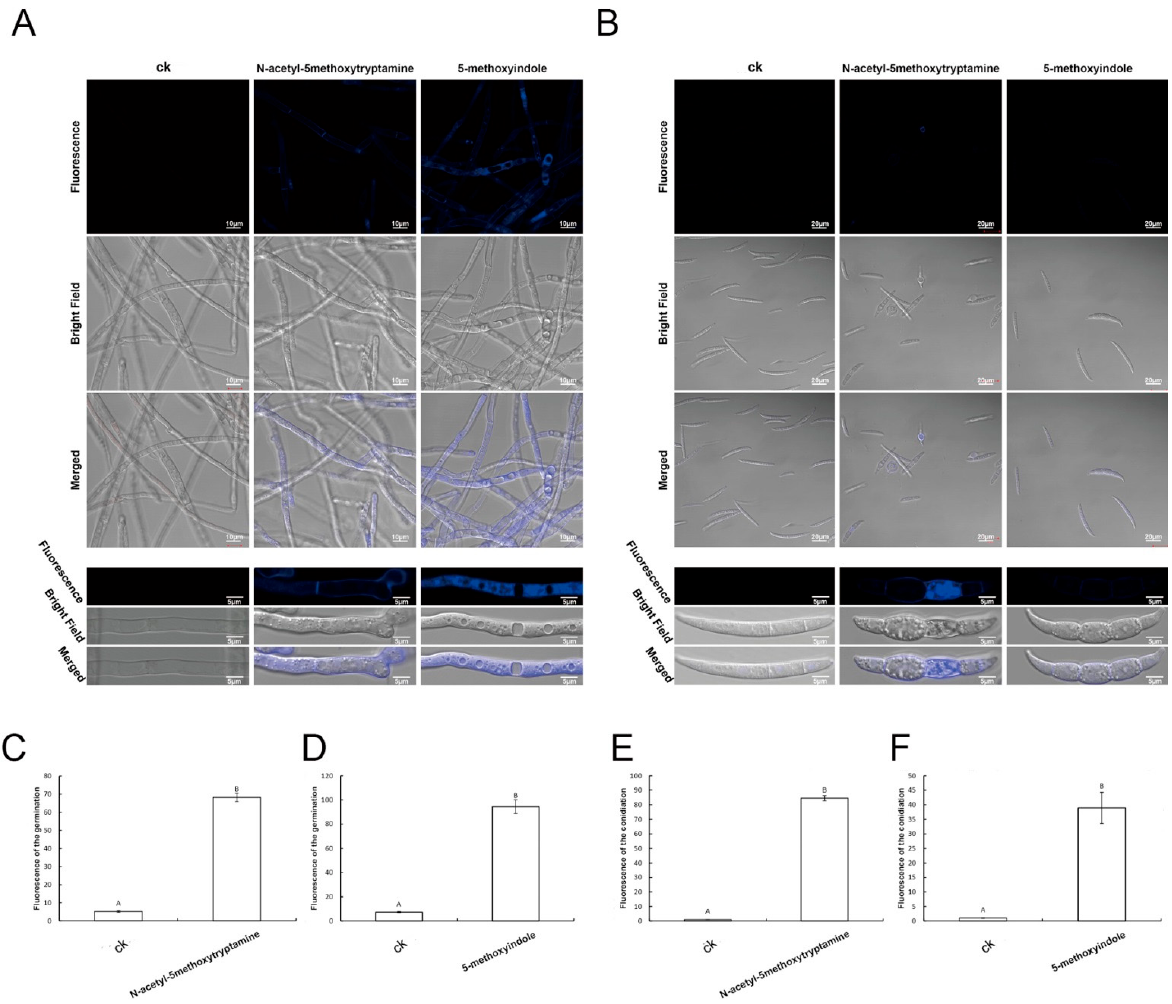
Figure 7. ( A , B ) Detection of F. graminearum hyphae and conidia viability based on fluorescein Hoechst staining after treatment with 4 mM melatonin and 0.1 mM 5-methoxyindole for 3 days; apoptotic cells with intact membranes show blue fluorescence; 0.05% (vol/vol) methanol/water served as the ck; ( C , D ) analysis of the average fluorescence of the F. graminearum hyphae after treating with the melatonin and 5-methoxyindole for 3 days; ( E , F ) analysis of the average fluorescence of the F. graminearum conidia after treating with the melatonin and 5-methoxyindole for 3 days. The error bars represent the mean standard deviation of each treatment repeated three times with three replicates. The letters above the columns indicate significant differences. The significant difference between the treatments was determined through Tukey’s HSD test at p ≤ 0.05. The higher level of green fluorescence indicates the high level of ROS induction in F. graminearum exposed to the melatonin and 5-methoxyindole.